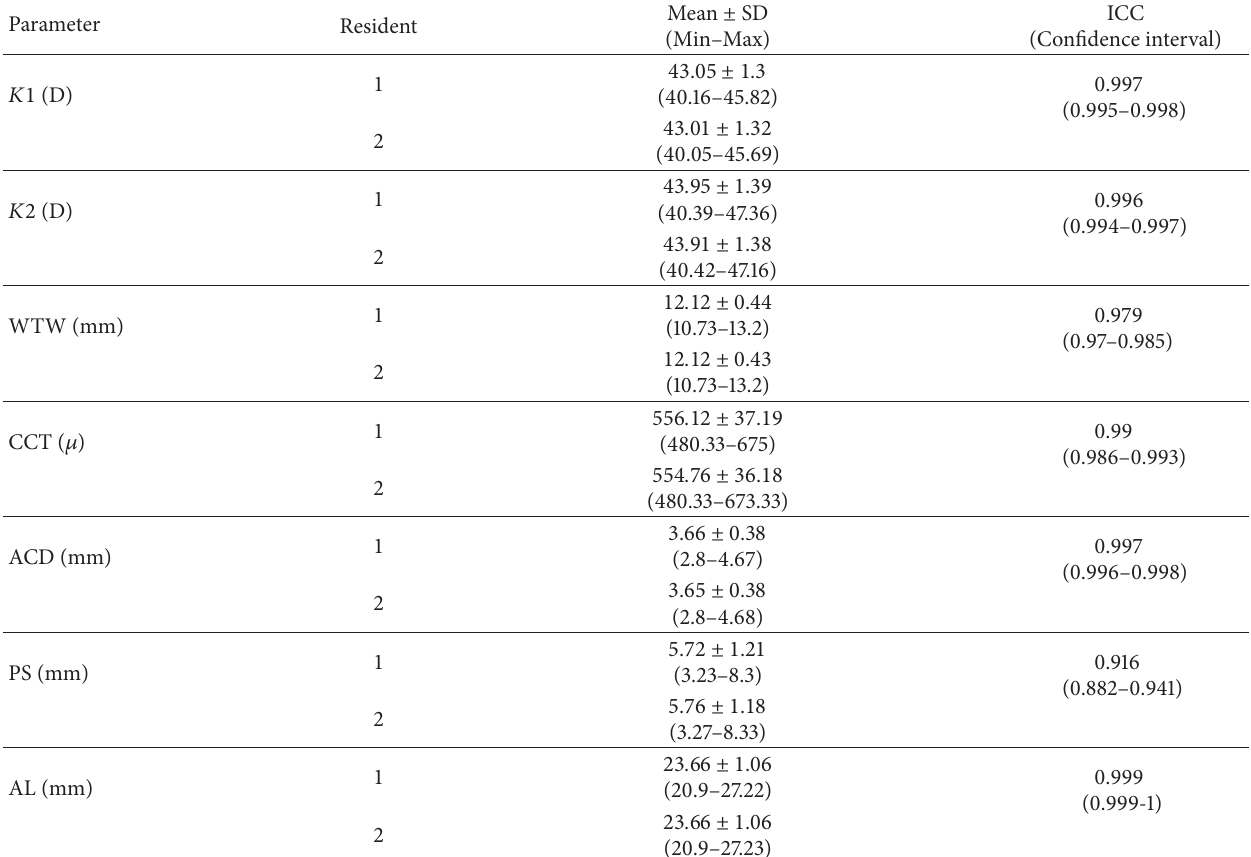
Table 3: Comparison of three consecutive biometric measurement means obtained by both ophthalmology residents (Reproducibility).